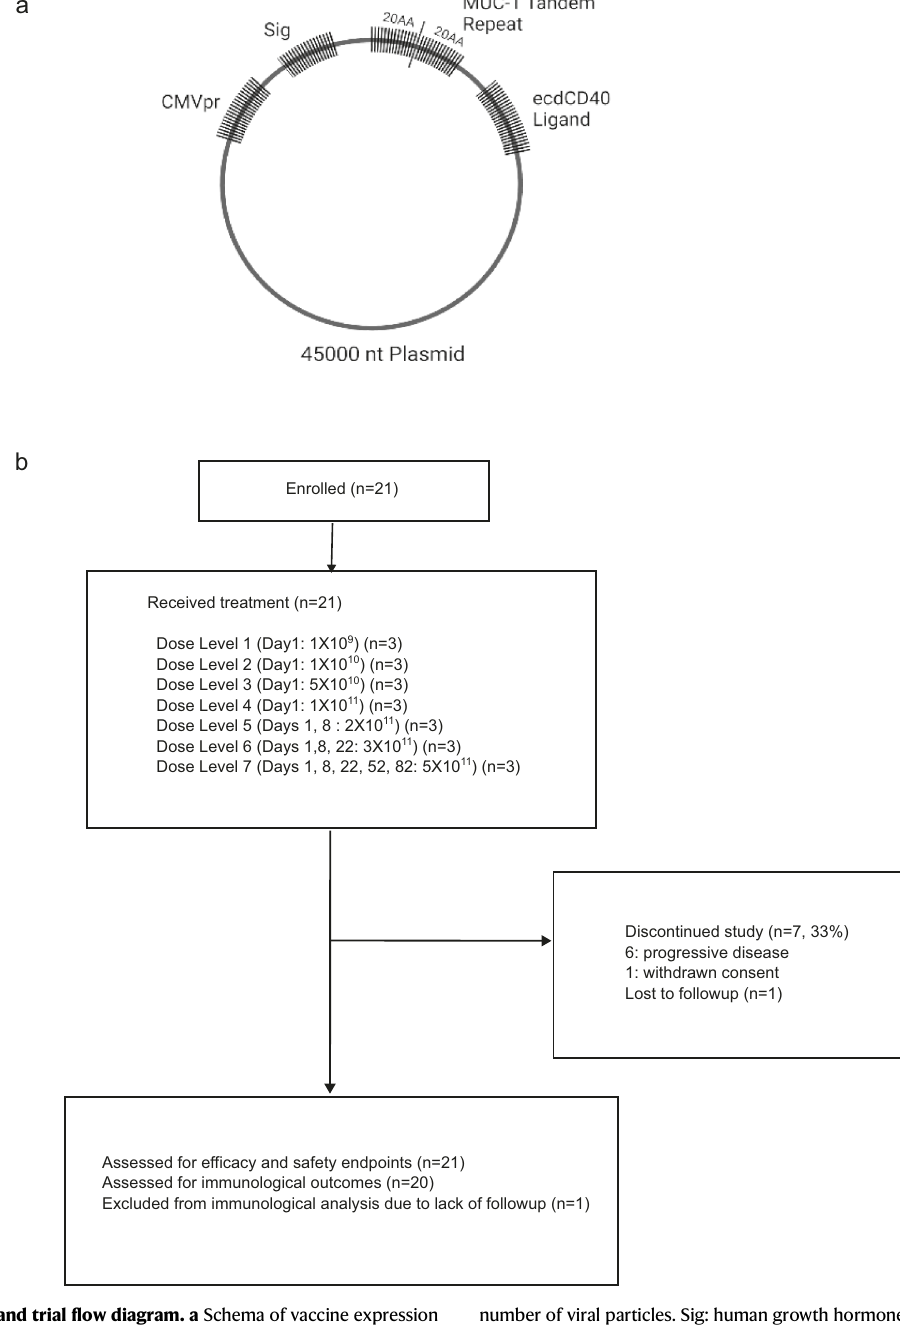
number of viral particles. Sig: human growth hormone signal peptide. CMVpr: cytomegalovirus promoter, ecd:extracellular domain, nt: